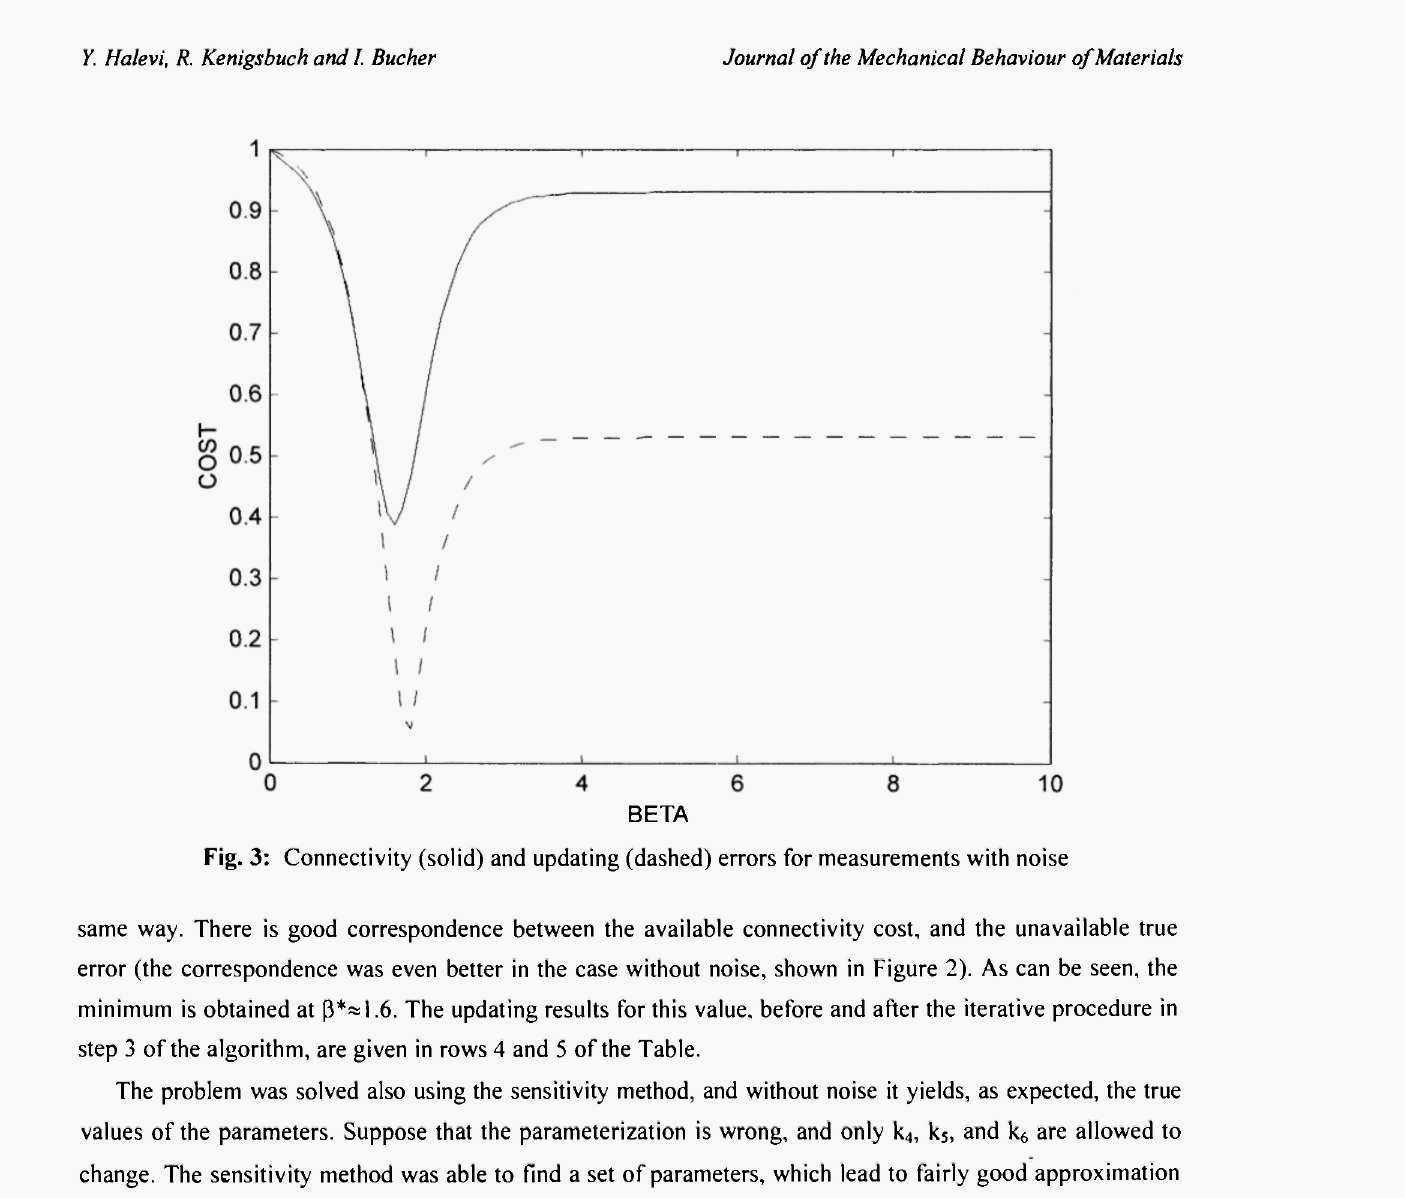
same way. There is good correspondence between the available connectivity cost, and the unavailable true error (the correspondence was even better in the case without noise, shown in Figure 2). As can be seen, the minimum is obtained at β*«1.6. The updating results for this value, before and after the iterative procedure in step 3 of the algorithm, are given in rows 4 and 5 of the Table. The problem was solved also using the sensitivity method, and without noise it yields, as expected, the true values of the parameters. Suppose that the parameterization is wrong, and only k 4 , k 5 , and k 6 are allowed to change. The sensitivity method was able to find a set of parameters, which lead to fairly good approximation of the frequencies, yet they do not represent the actual change in the system. The proposed algorithm, under the same circumstances, was not 'fooled' by the data and did not move at all, indicating that the parameterization should be